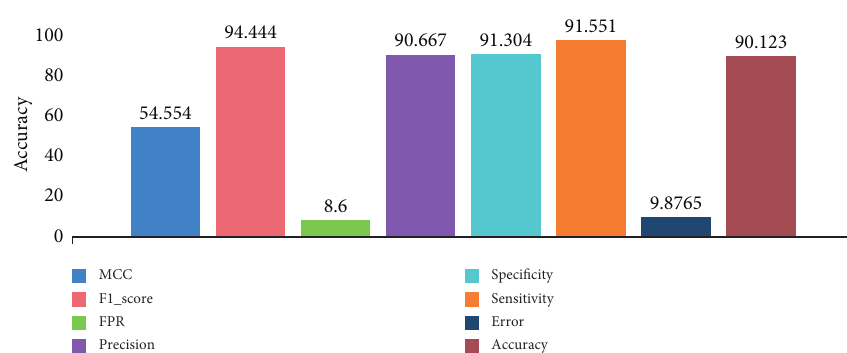
Figure 7: Overall values of COVID-19 with only 20 cases of Non-COVID-19 cases.